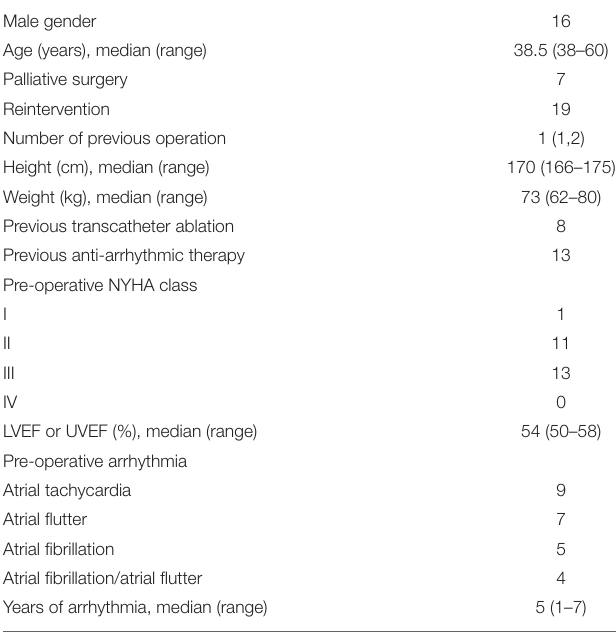
TABLE 1 | Demographics and baseline characteristics of